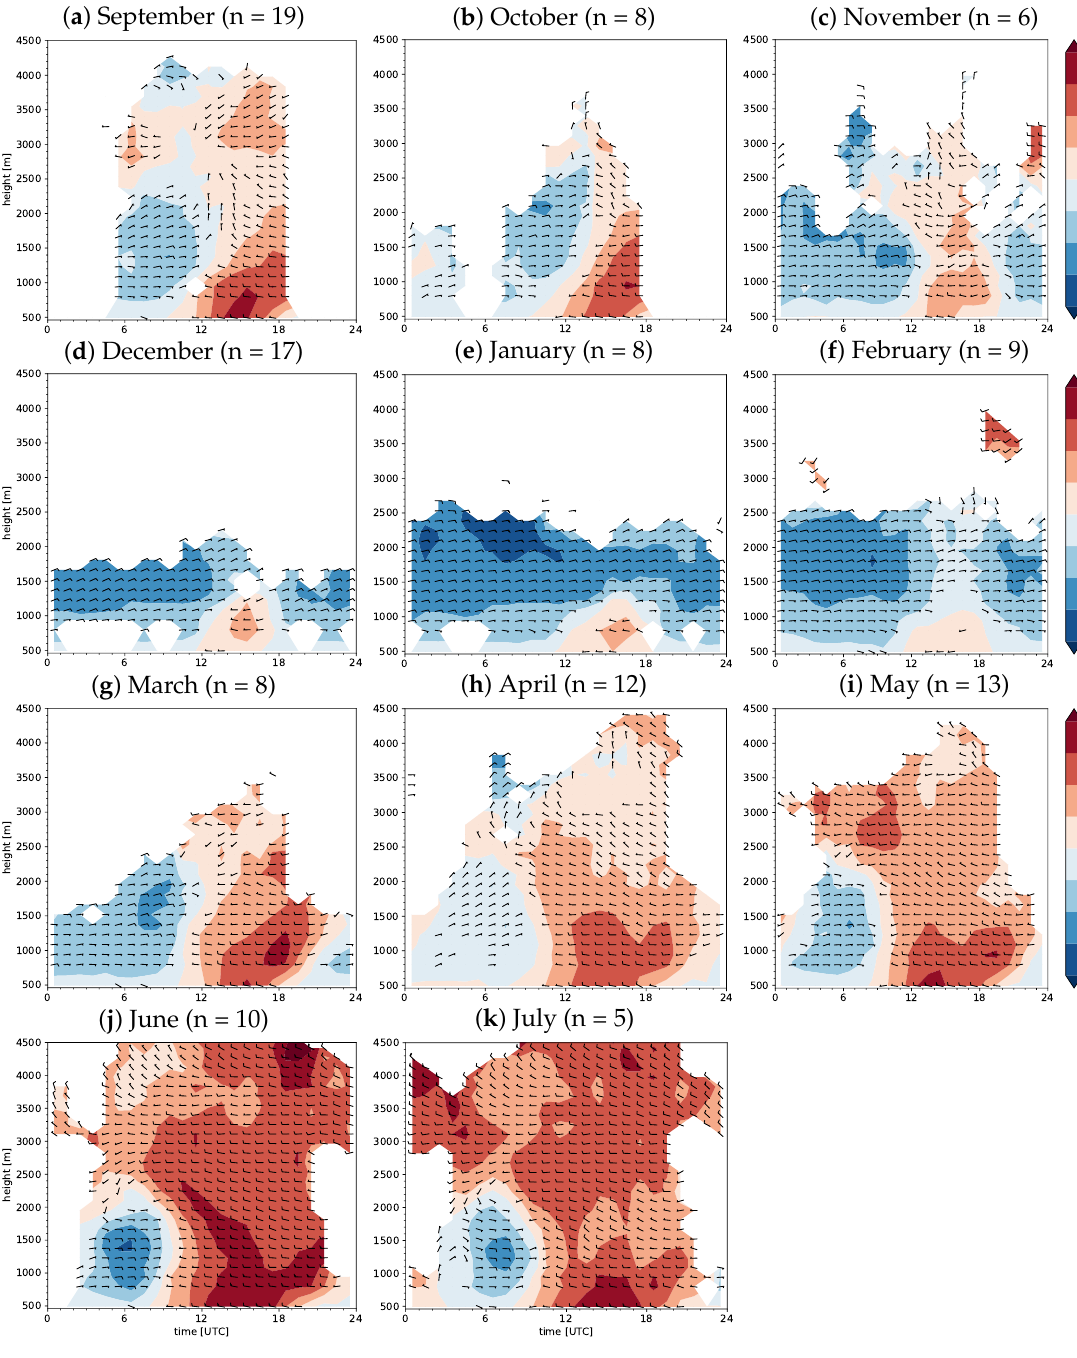
Figure 10. As in Figure 9, but for the high-mode wind profiler